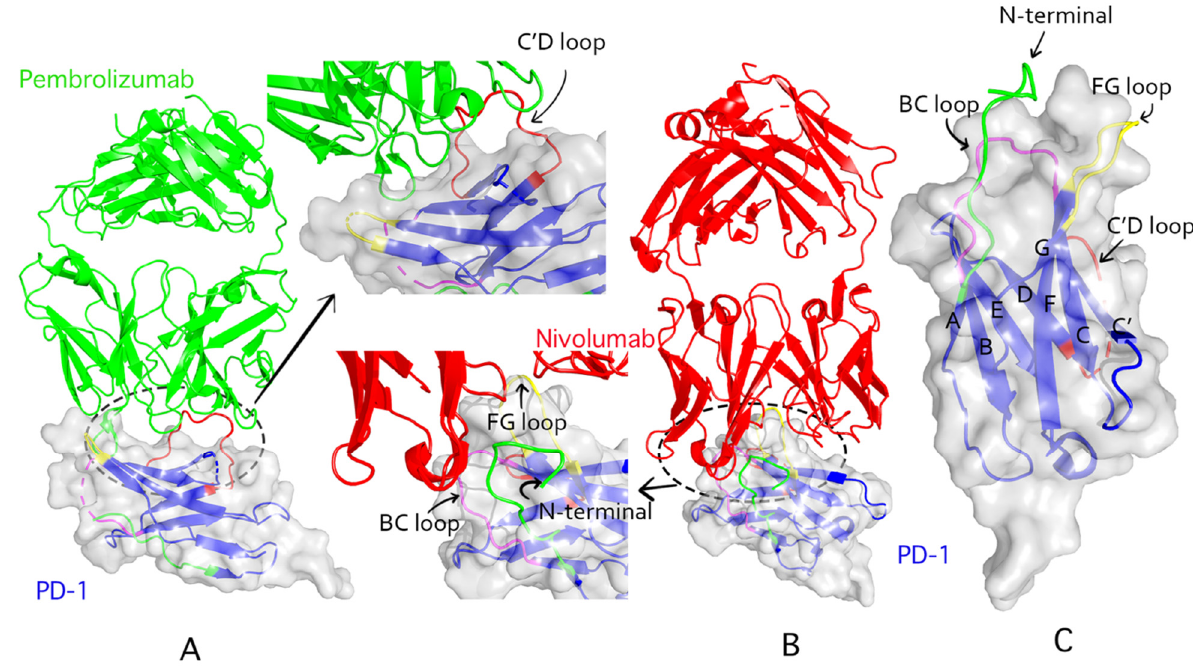
Figure 2. Structural interactions of pembrolizumab and nivolumab with PD-1. ( A ): Pembrolizumab complexed (PDB ID: 5jxe) with human PD-1 extracellular domain. The light green ribbons represent pembrolizumab. PD-1 is represented by the transparent blue ribbons. ( B ): The complex of nivolumab (PDB ID: 5wt9) and PD-1 extracellular domain; the nivolumab is represented by red ribbons. ( C ): The extracellular domain of human PD-1 (PDB ID: 3rrq). The BC loop, C’D loop, FG loop, and N-terminal domain are in magenta, red, yellow, and green colors, respectively.